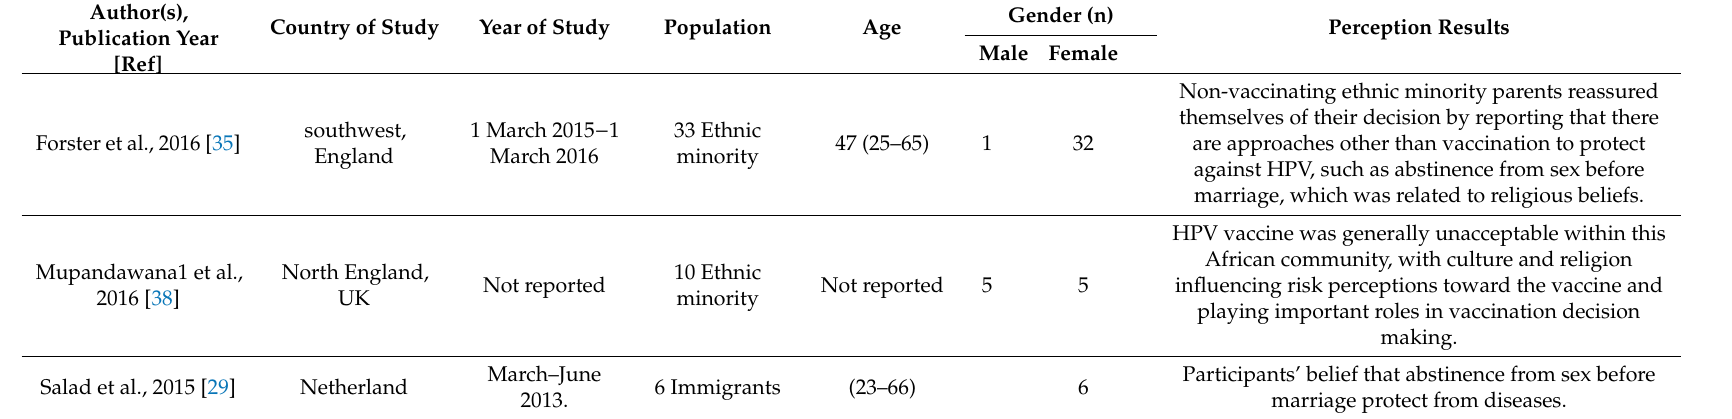
Table 4. Studies reporting perceptions of immigrants about HPV vaccine (12